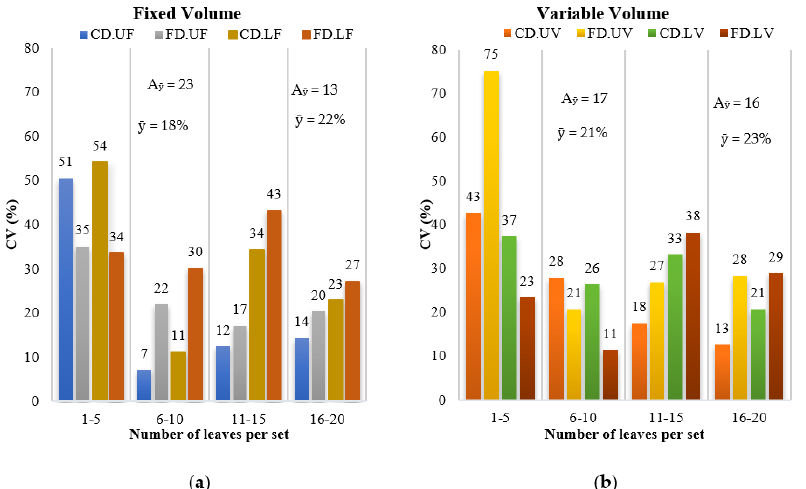
Figure 1. Coefficients of variation (CVs) of the amount of tracer for each number of leaves per set within each droplet size, plant canopy, and fixed ( a ) and variable ( b ) volume of extraction solution in coffee crops. CD: coarse droplets, FD: fine droplets, U: upper canopy, L: lower canopy, F: fixed volume, V: variable volume; A ȳ : amplitude; ȳ : average. For the 6–10 and 16–20 leaf intervals, the variability in the amount of tracer was lower. For the 6–10 interval, the mean CVs between the parts of the coffee plant were 18 and 21% for fixed and variable volumes, respectively (Figure 1). For the 16–20 interval, the averages were 22% and 23% under the same conditions. The smallest amplitudes between the minimum and maximum CVs within the same interval were obtained for the variable volume, with 17% and 16% for the 6–10 and 16–20 leaf intervals, respectively. Thus, as the two intervals had similar CV values, the smaller (6–10 leaves) was selected and the basic unit size of 10 leaves per set and 100 mL of extraction solution was determined. 2.2. The Optimal Sample Size for Spray Deposition Trials The spray deposition on coffee leaves was greater and more uniform in the application with fine droplets, obtaining estimates of 0.72 and 0.86 μ g cm − 2 in the upper and lower parts, respectively (Table 2). In the application with coarse droplets, the spray deposition was approximately 50% lower than that with the fine droplets and was mainly concentrated in the lower part, with a spray deposition of 0.38 and 0.52 μ g cm − 2 in the upper and lower parts, respectively. According to these foliar depositions, the soil runoff obtained higher estimates with coarse droplets (21.16 μ g cm − 2 ) compared to that with fine droplets (15.06 μ g cm − 2 ).